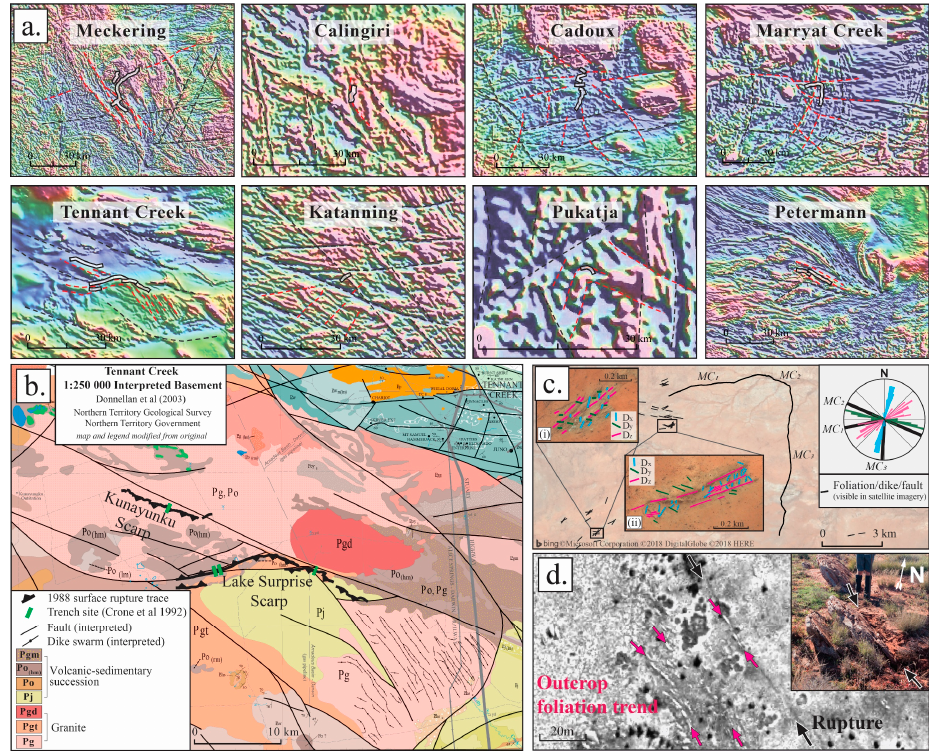
Figure 2. Examples of the relationship between geophysical data and surface outcrop to historic ruptures ( a ) national total magnetic intensity map with ruptures overlaid, and dashed lines indicating linear anomalies ( b ) interpreted basement geology around the three Tennant Creek scarps (no basement outcrops at the surface) demonstrating strong correlation between intrusive / lithological boundaries, basement faults, and historic surface rupture (legend heavily simplified to show lithologies around the ruptures, more details in EarthArXiv report [126] legend and original map. Map used under creative commons NT Gov) ( c ) examples of surface outcrop structures visible in basement around the Marryat Creek rupture including three sets of dike / foliation / fault orientations coincident with the three major orientations of the historic rupture, uninterpreted satellite imagery insets (i) and (ii) available in Marryat Creek EarthArXiv report [123] ( d ) example of mylonite foliation orientation along a section of the Petermann rupture where outcrop occurs within the primary rupture zone.